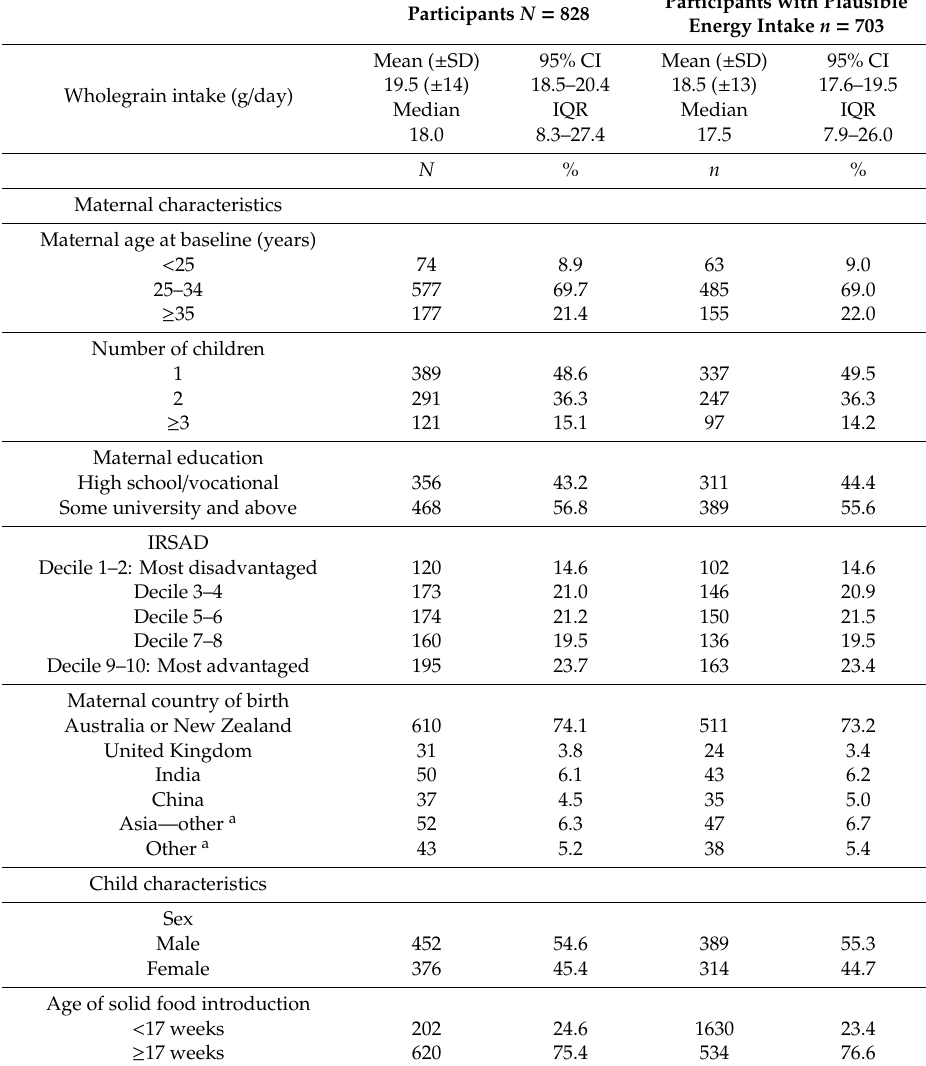
Table 1. Participant